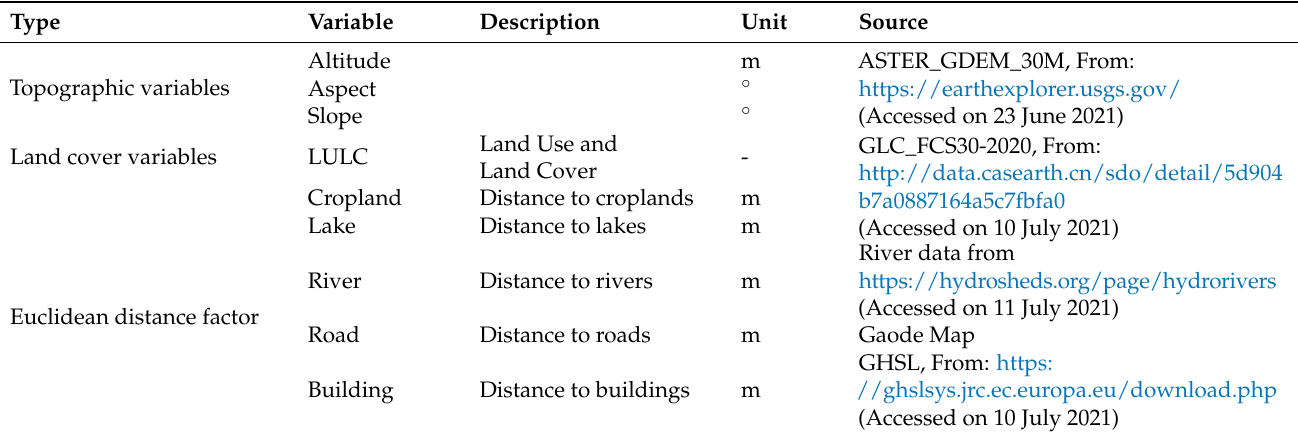
Table 1. Environmental variables used in the